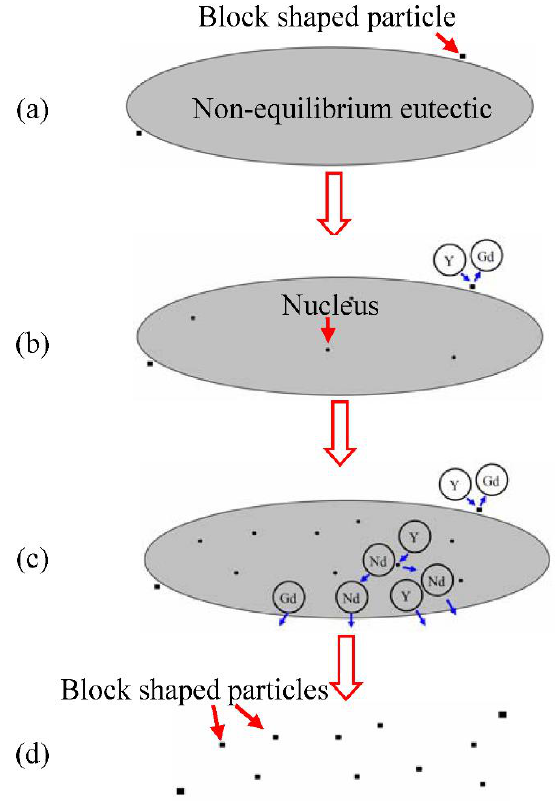
Figure 8. Schematic diagram of the generation process of block shaped particles: ( a ) As-cast condition, ( b ) Composition variation of the particle formed at as-cast condition, ( c ) Particle formation process in the non-equilibrium eutectic, ( d ) Solution treated condition.